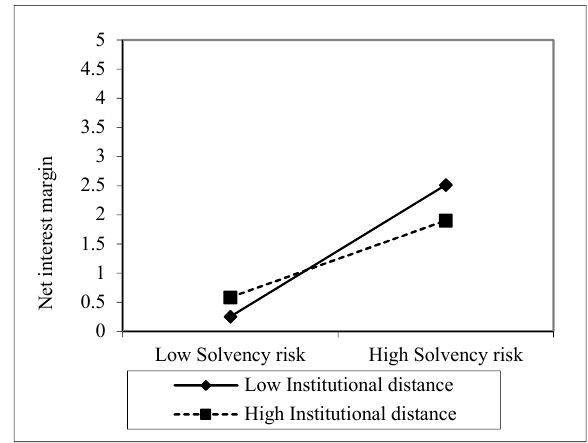
Figure 10. Solvency Risk × Institutional Distance.